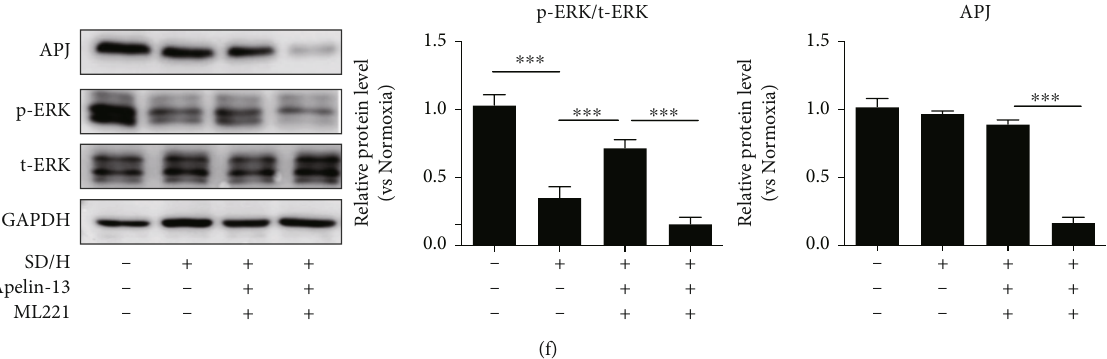
Figure 2: Apelin-13 pretreatment inhibits SD/H-induced mitochondrial fragmentation in MSCs via regulation of the ERK signaling pathway. (a) Western blotting and quantitative analysis for p-ERK and t-ERK protein level in MSCs and Apelin-13-pretreated MSCs under normoxic or SD/H conditions. (b) Western blotting and quantitative analysis for p-ERK, t-ERK, p-Drp1 ser616, and Drp1 protein level in MSCs, Apelin-13-pretreated MSCs, or Apelin-13-pretreated MSCs with U0126 under SD/H condition. (c) Representative images of MitoTracker staining and quantitative analysis of the number of mitochondria and mean mitochondrial area in MSCs, Apelin-13- pretreated MSCs or Apelin-13-pretreated MSCs with U0126 under SD/H condition. (d) Quantitative analysis of ROS generation in MSCs, Apelin-13-pretreated MSCs, or Apelin-13-pretreated MSCs with U0126 under SD/H condition. (e) Quantitative analysis of the apoptotic rate of MSCs, Apelin-13-pretreated MSCs, or Apelin-13-pretreated MSCs with U0126 under SD/H condition. (f) Western blotting and quantitative analysis for APJ, p-ERK, and t-ERK protein level in MSCs, Apelin-13-pretreated MSCs, or Apelin-13-pretreated MSCs with ML221 under normoxic or SD/H conditions. n = 3 biological replicates for each group. Data are expressed as mean ± SD . ∗∗ p < 0 : 01 , ∗∗∗ p < 0 : 001